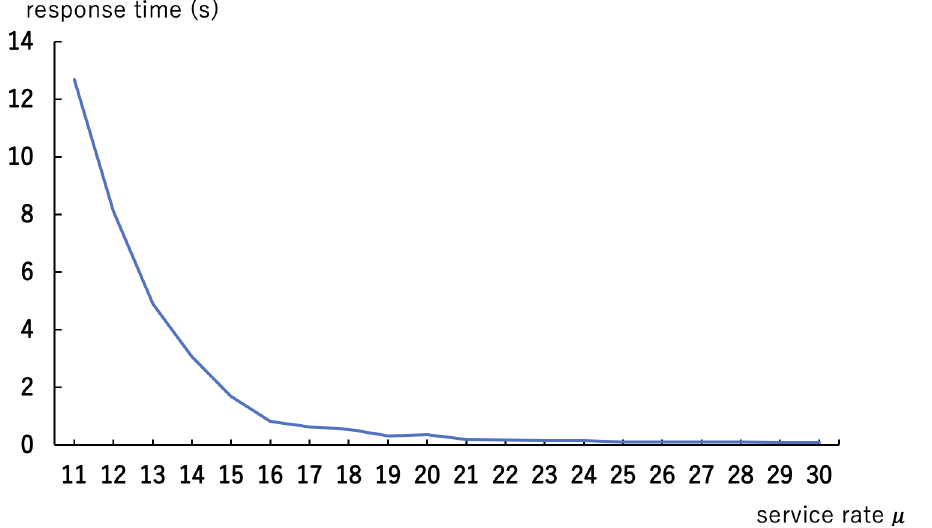
Figure 4. Varation curve of the average response times with service rate µ